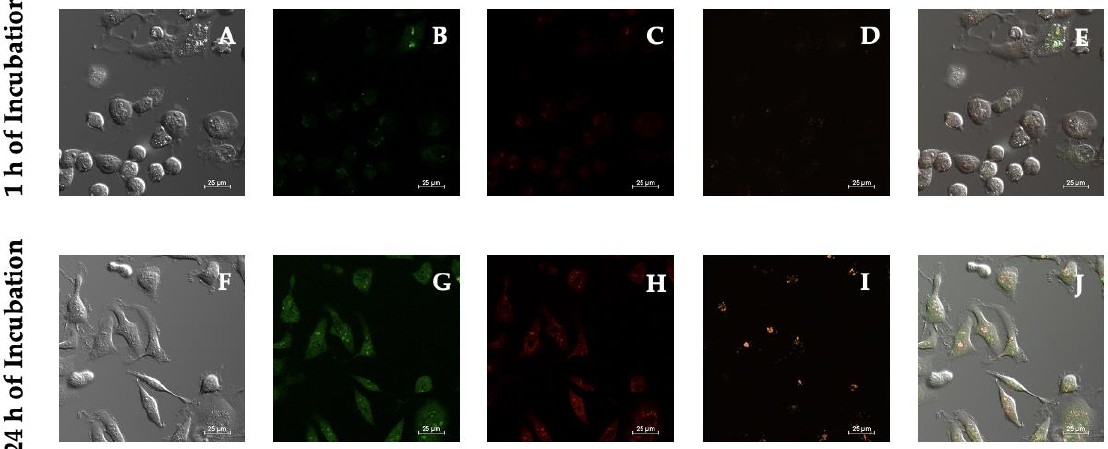
Figure 6. ROS/Superoxide detection microscopy studies in MDA-MB-231 live cells. Phase-contrast ( A , F ) of MDA-MB-231 cells after 1 and 24 h of incubation with PSI-LHCI (12.5 µg/mL). Green cytoplasmic oxidative stress signal viewed with the FITC filter ( B , G ); red nuclear superoxide stain visualized with the CY3 filter ( C , H ); orange PSI-LHCI detected with the Alexa Fluor 555 filter ( D , I ). Merge pictures are presented in ( E , J ). All images were taken at 20 × magnification. Scale bars, 25 µ